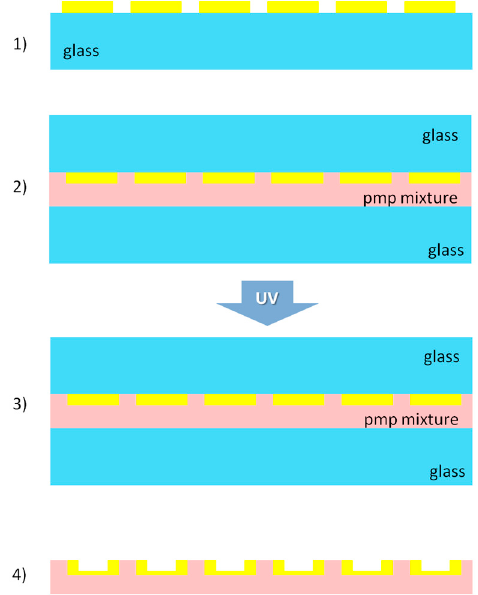
Figure 2. Sketch of the plasmonic photomobile polymer (PMP) fabrication procedure. ( 1 ) Plasmonic crystal is fabricated on a rigid glass slide substrate (plasmonic crystal on glass slide, PCGS); ( 2 ) PMP mixture is placed in a sandwich consisting of PCGS and another glass slide separated by mylar spacers; ( 3 ) ultraviolet irradiation on the PCGS side; ( 4 ) after irradiation, the PMP film is peeled off from the system, resulting in the plasmonic PMP structure.